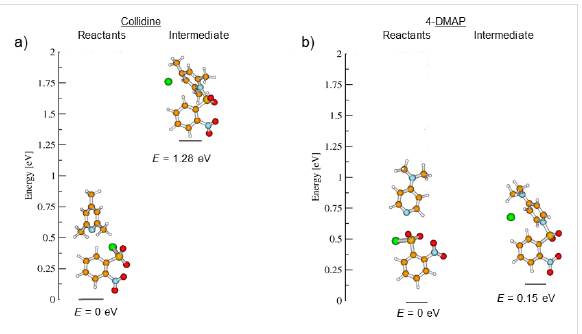
Figure 4: DFT calculations for the reaction of o -NBS-Cl with a) colli- dine and b) DMAP. The structure of the reactants and the energies calculated appear on the left while the structure and calculated ener- gies of the intermediates appear on the right of each